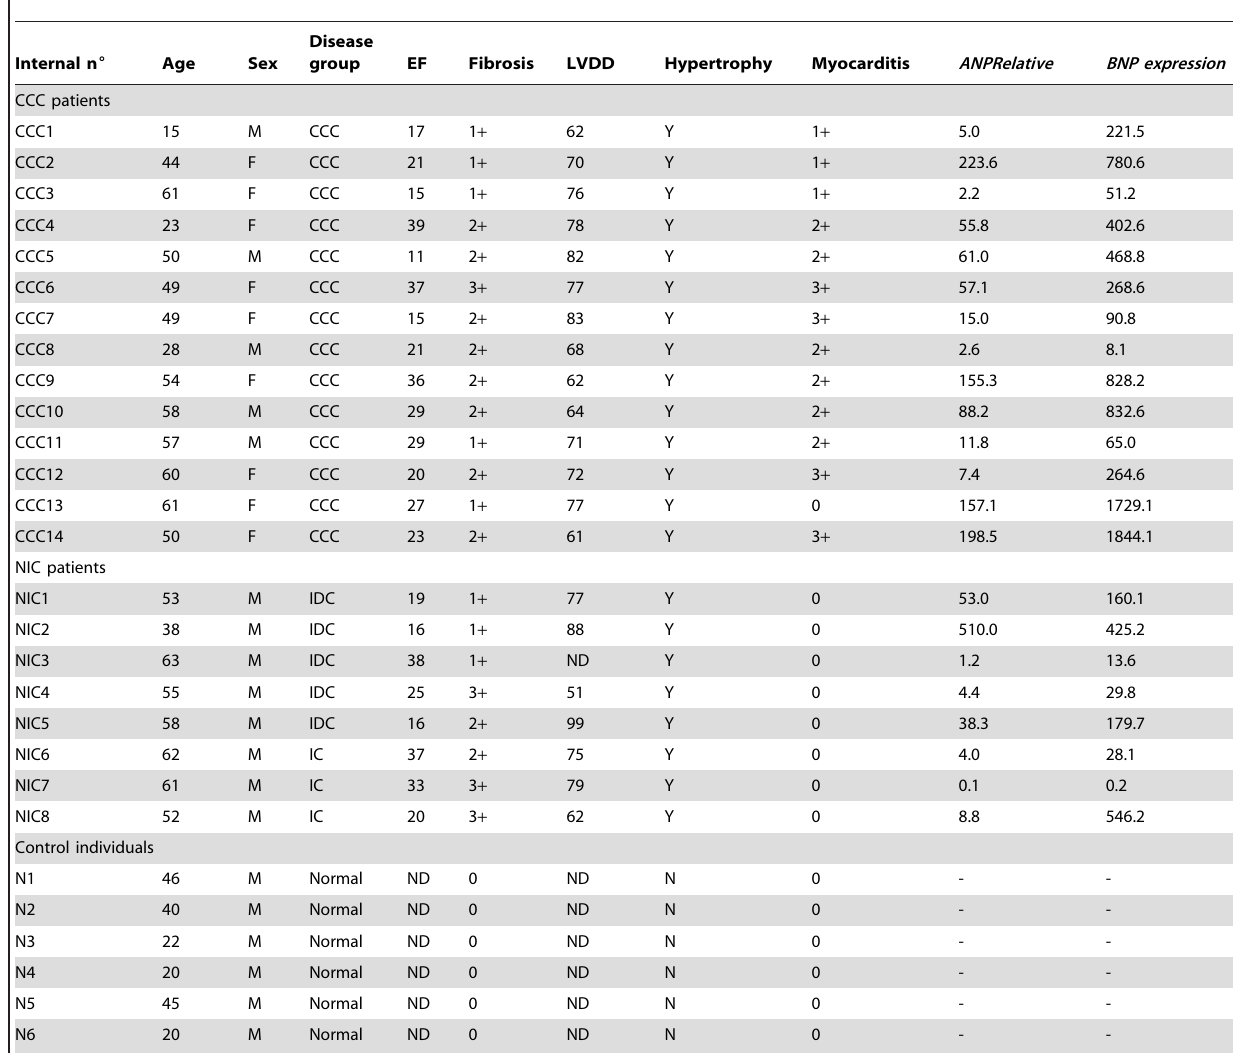
Table 1. Characteristics of patients and control donors whose myocardial samples were used in gene expression